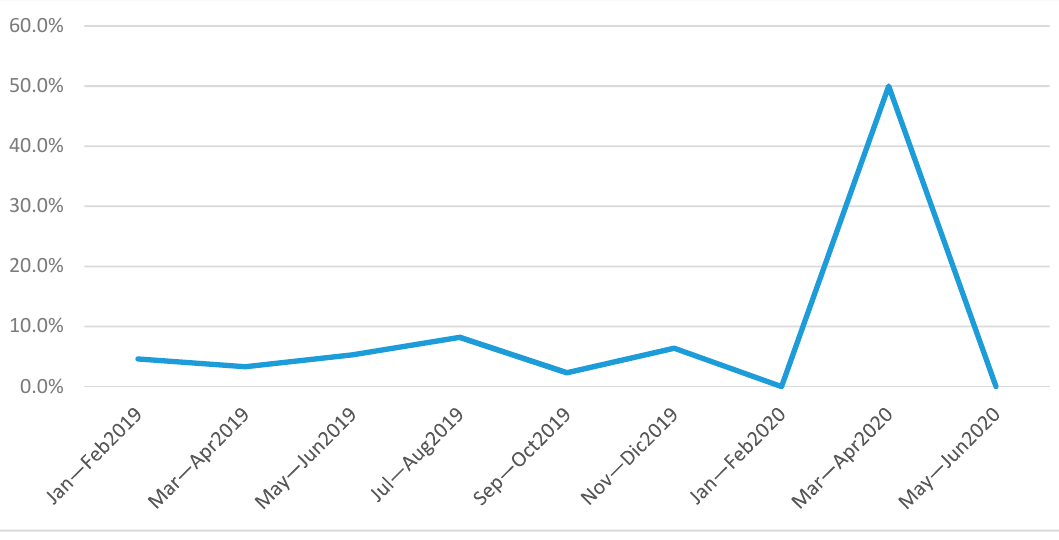
J. Clin. Med. 2020 , 9 , x FOR PEER REVIEW Figure 2. The trend of incidence of CRE acquisition colonization. Figure 2. The trend of incidence of CRE acquisition colonization.